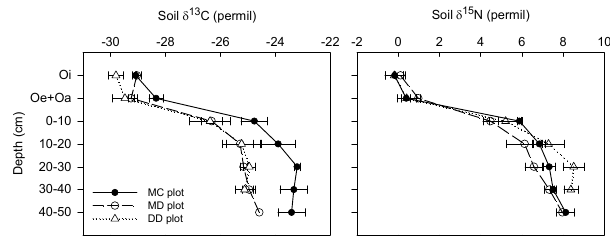
Figure 2. Soil profiles of 13 C and 15 N isotope abundance at the MC, MD, and DD plot. Error bars represent standard deviation ( n =